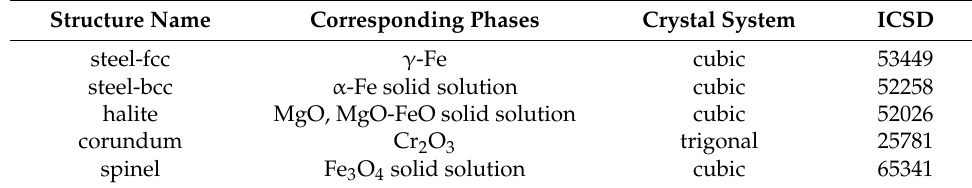
Table 4. Overview of used structure models for the Rietveld refinement of 316L–40MgO / AlSi7Mg0.3